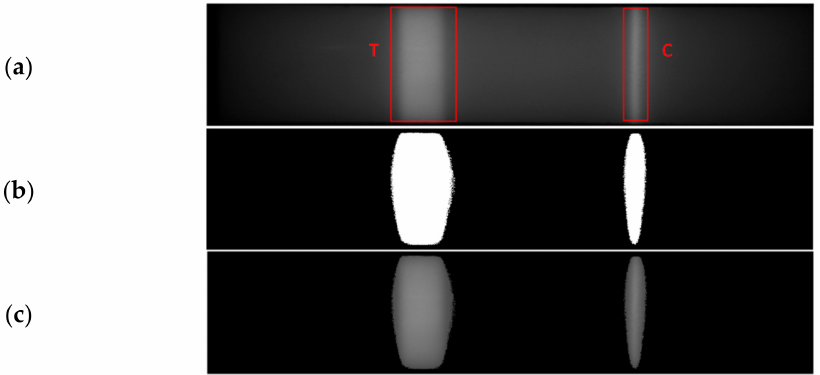
Figure 9. ( a ) The test (T) and control (C) lines indicated for a sample image captured. ( b ) Correspond- ing binary maps obtained. ( c ) Test and Control regions segmented